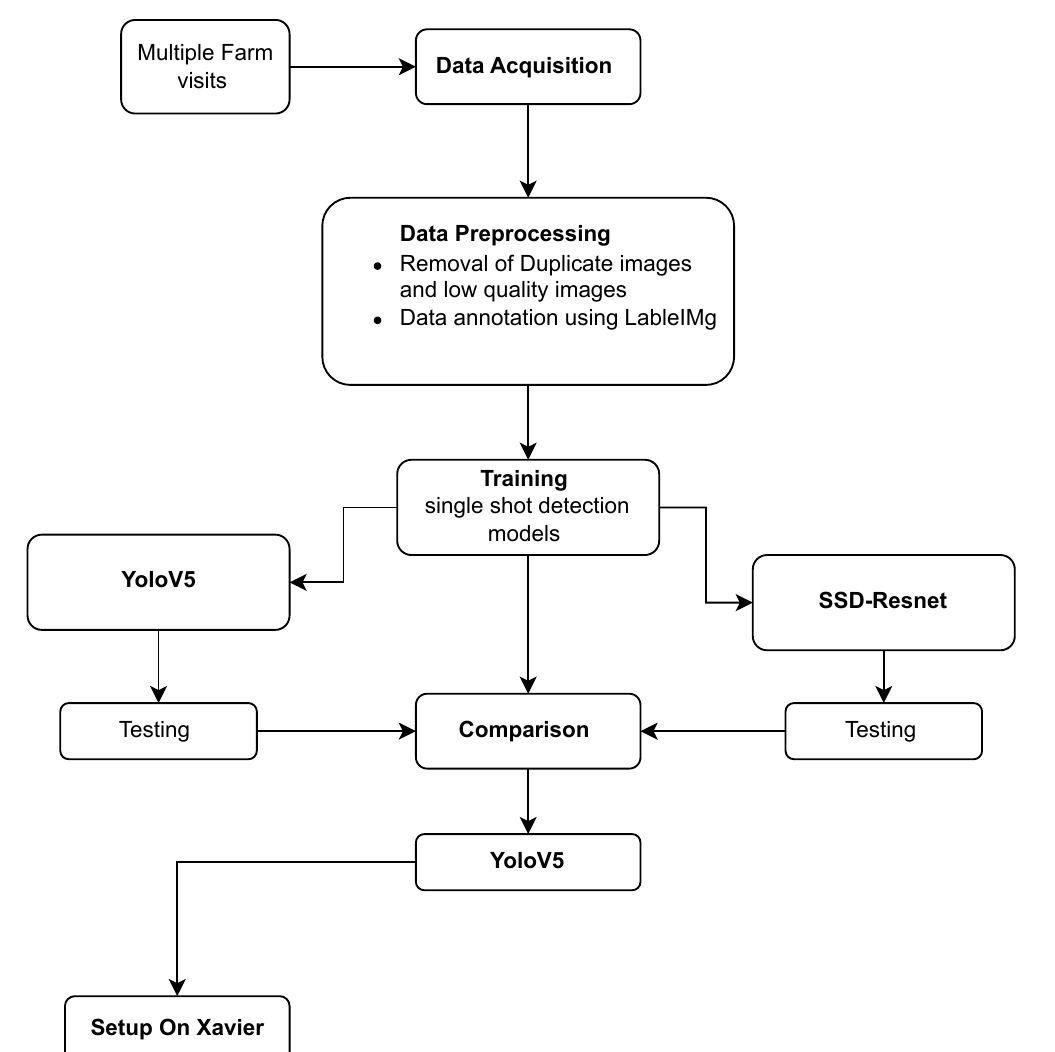
Figure 1. Workflow for the development of the weed detection